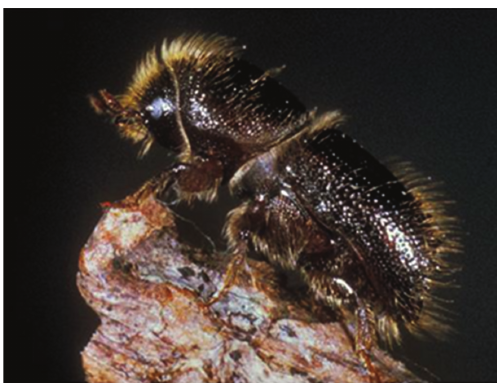
Figure 1: The European spruce bark beetle, Ips typographus . Photo: G¨oran